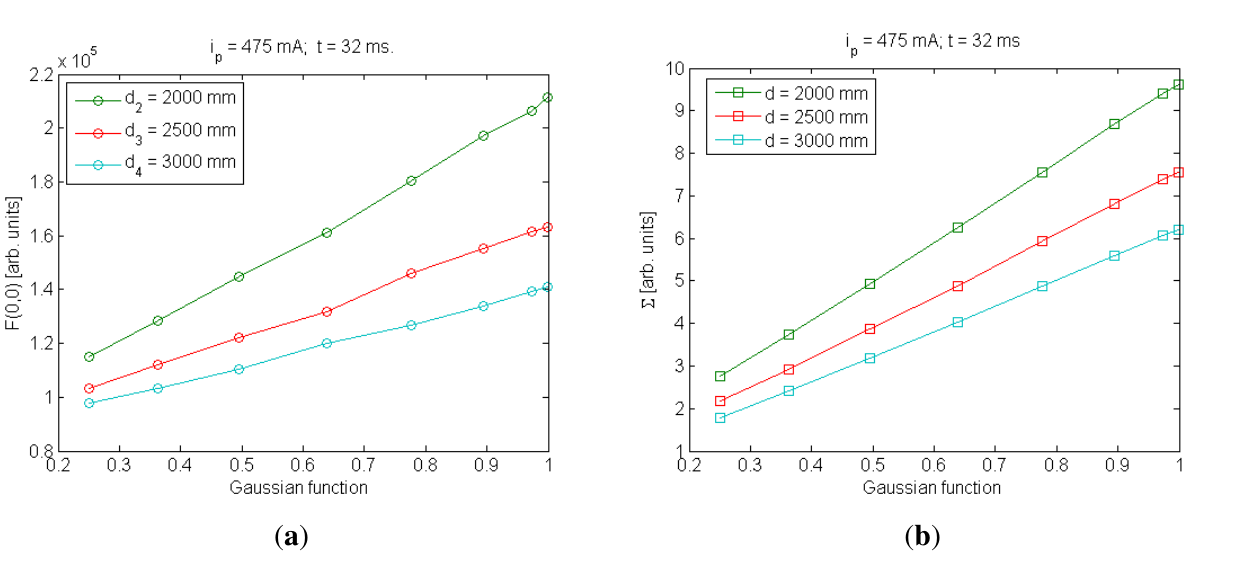
Figure 6. Other additional parameters extracted from IRED images and their relationship with the function used for IRED emission pattern modeling, ( a ) behavior for F (0 , 0) ; ( b ) behavior for Σ .